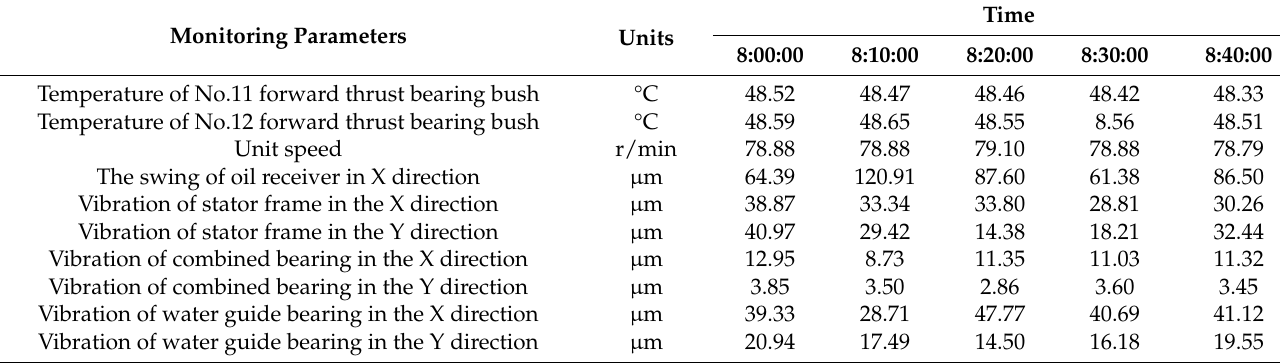
Table 1. Part of the original data of some of 107 measuring parameters on 9 October 2015. Monitoring